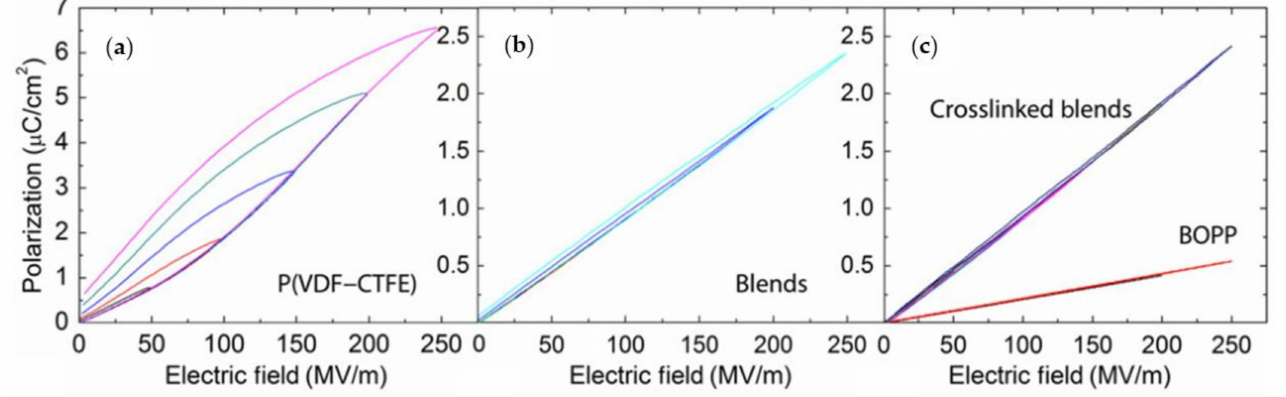
Figure 7. ( a ) Polarization-electric field (D-E) response of P(VDF-CTFE) 91/9mol%; ( b ) P(VDF- CTFE)/ECTFE 67/33 wt% blends; ( c ) P(VDF-CTFE)/ECTFE 67/33 wt% crosslinked blends with chemical crosslinking under unipolar-electric fields. Reprinted with permission from [93]. Copyright (2011), American Institute of